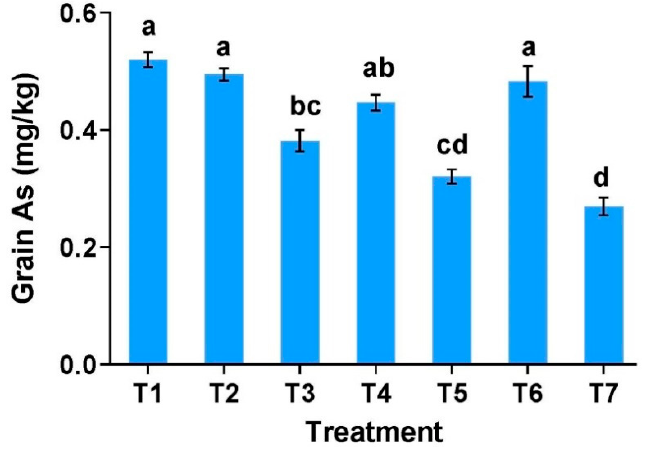
Figure 1. Effects of water management on arsenic accumulation in rice grain. Same letters do not differ significantly at 5% level of significance.